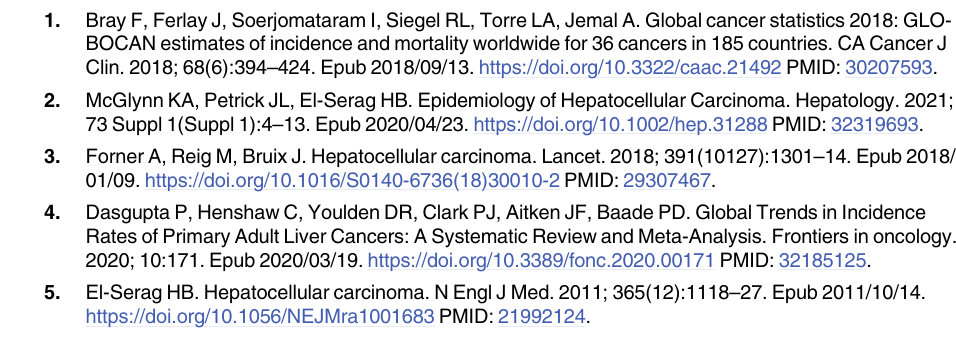
S1 Table. Macronutrient composition of animal diets. (PDF) S2 Table. Micronutrient composition of animal